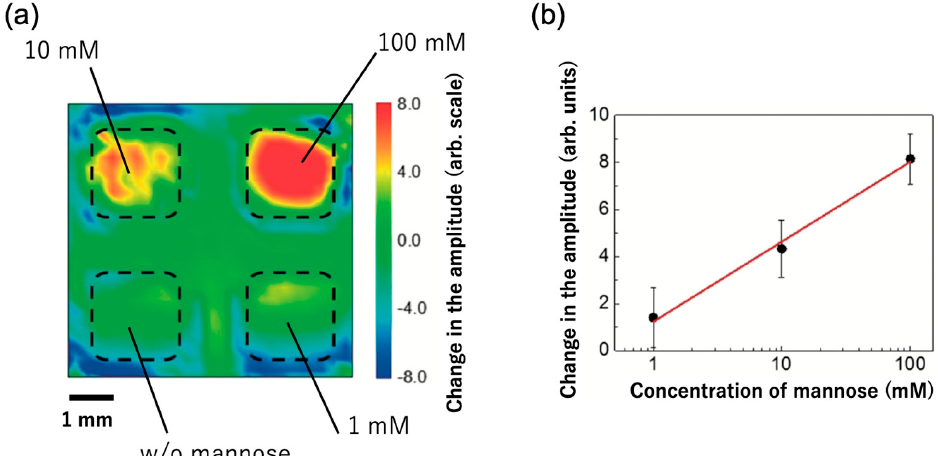
Figure 9. Amplitude changes in the THz pulses before and after the immune reaction. ( a ) Amplitude map (dashed lines indicate the well edges) and ( b ) amplitude change versus concentration of mannose dropped into the wells on the sensing